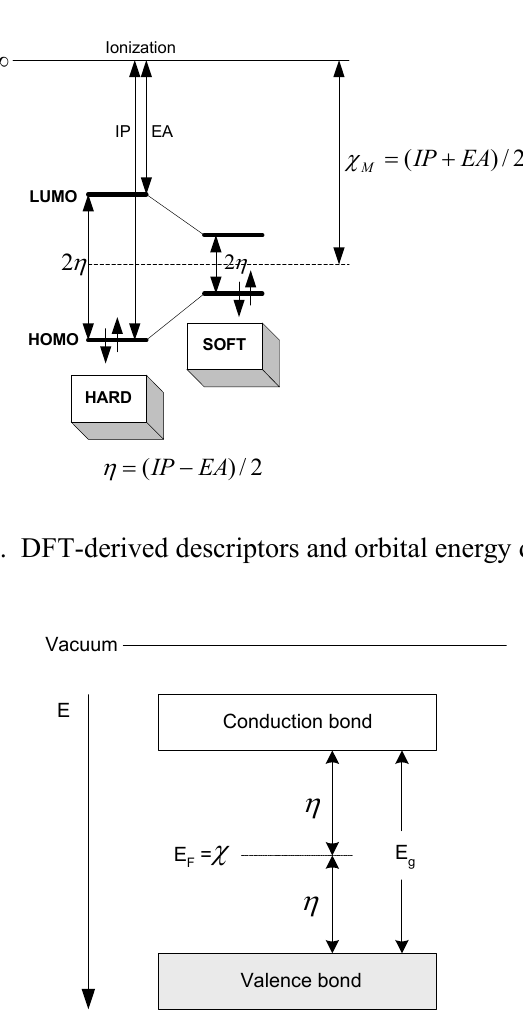
Figure 2 . Schematic diagram of electronic band structures of